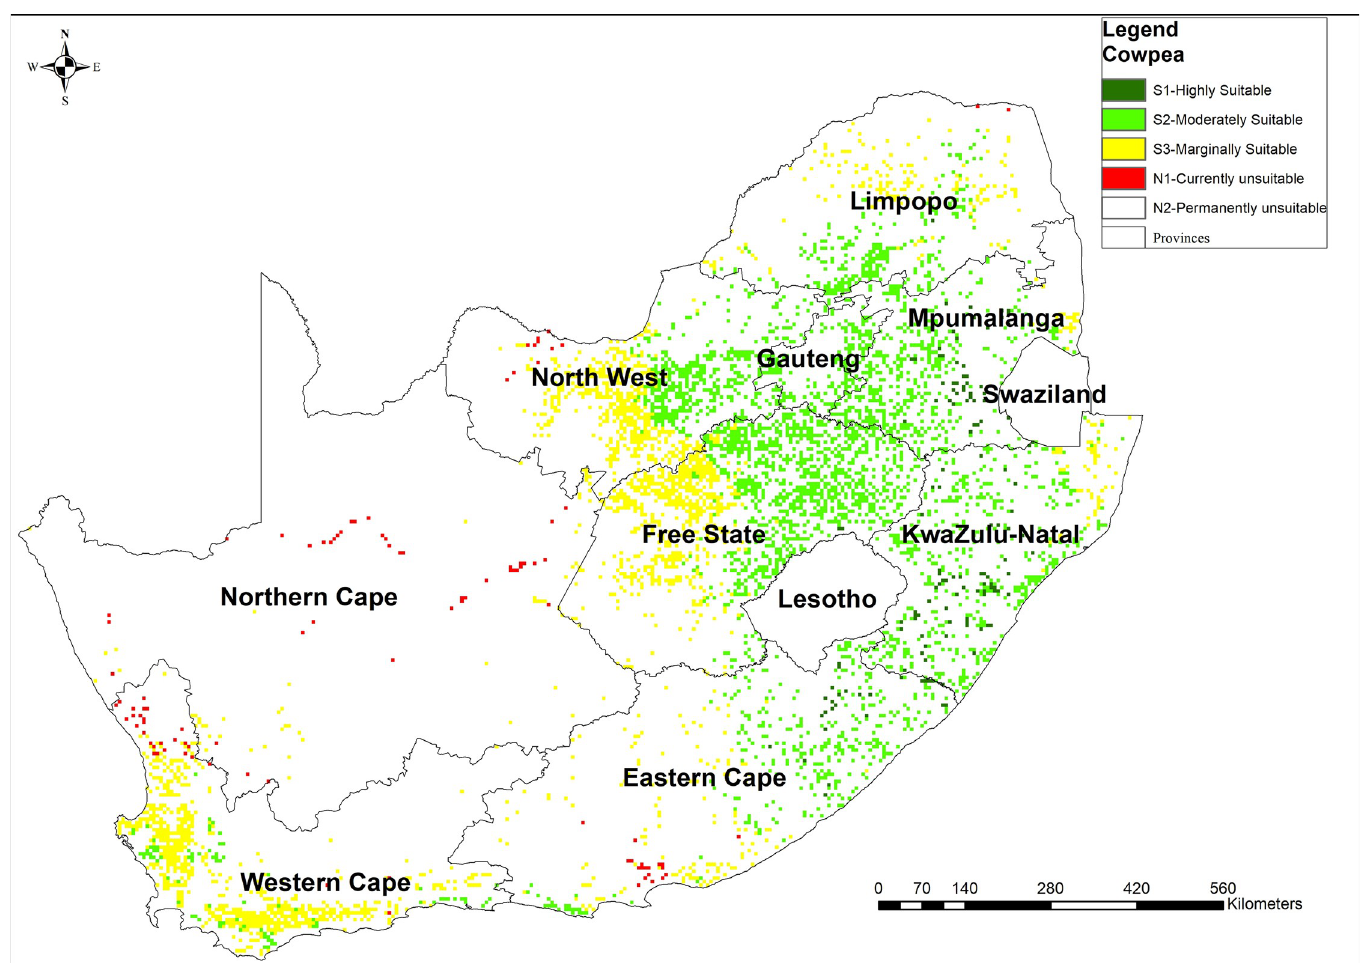
Fig 3. Suitability map for cowpea production in South Africa computed using MCDA-AHP and OWA operators [Source, South African Quaternary Catchments database , ( https://doi.org/10.6084/m9.figshare.13179881 ) , in ArcGIS 10 . 5] .